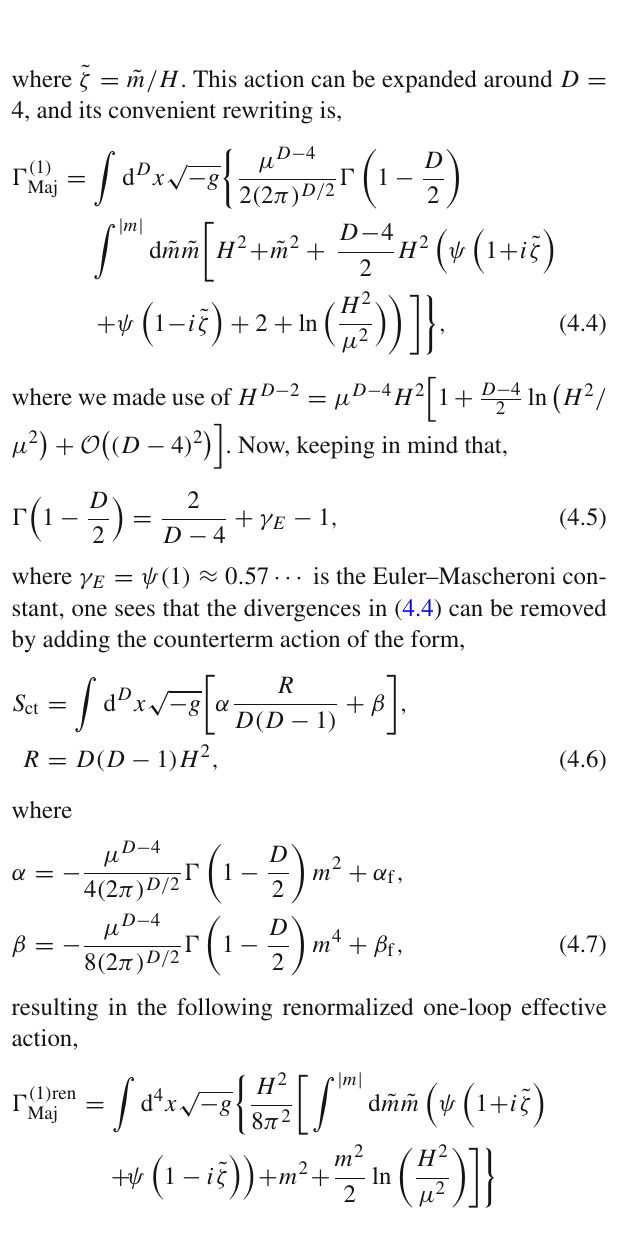
the exchange: (cid:3)( x ) → (cid:3)( x (cid:13) ) and (cid:3)( x (cid:13) ) → − (cid:3)( x ) . Although the exchange can be visualised by how the blue and red dots have changed theirposition,thisisonlyforavisualrepresentation.However,inreality such a distinction is not